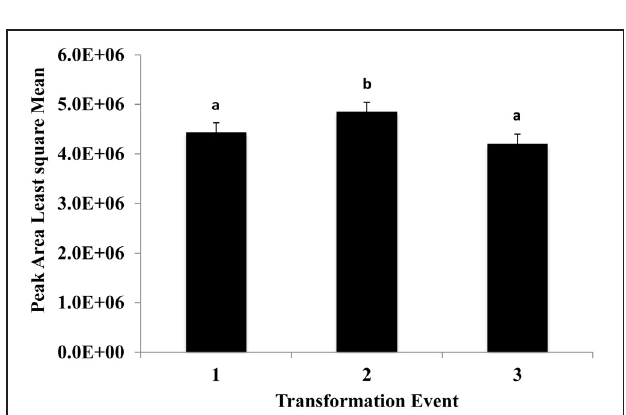
FIGURE 7 | The effect of three transformation events, 1, 2, and 3 (P344-2-4-1, P344-4-1-6, and P344-5-2-1, respectively) on mean peak areas of maize seed storage protein genes for maize seed endosperms transformed with the soybean ferritin transgene. Significant differences ( P < 0 . 05) are indicated with a different letter on top of each error bar.